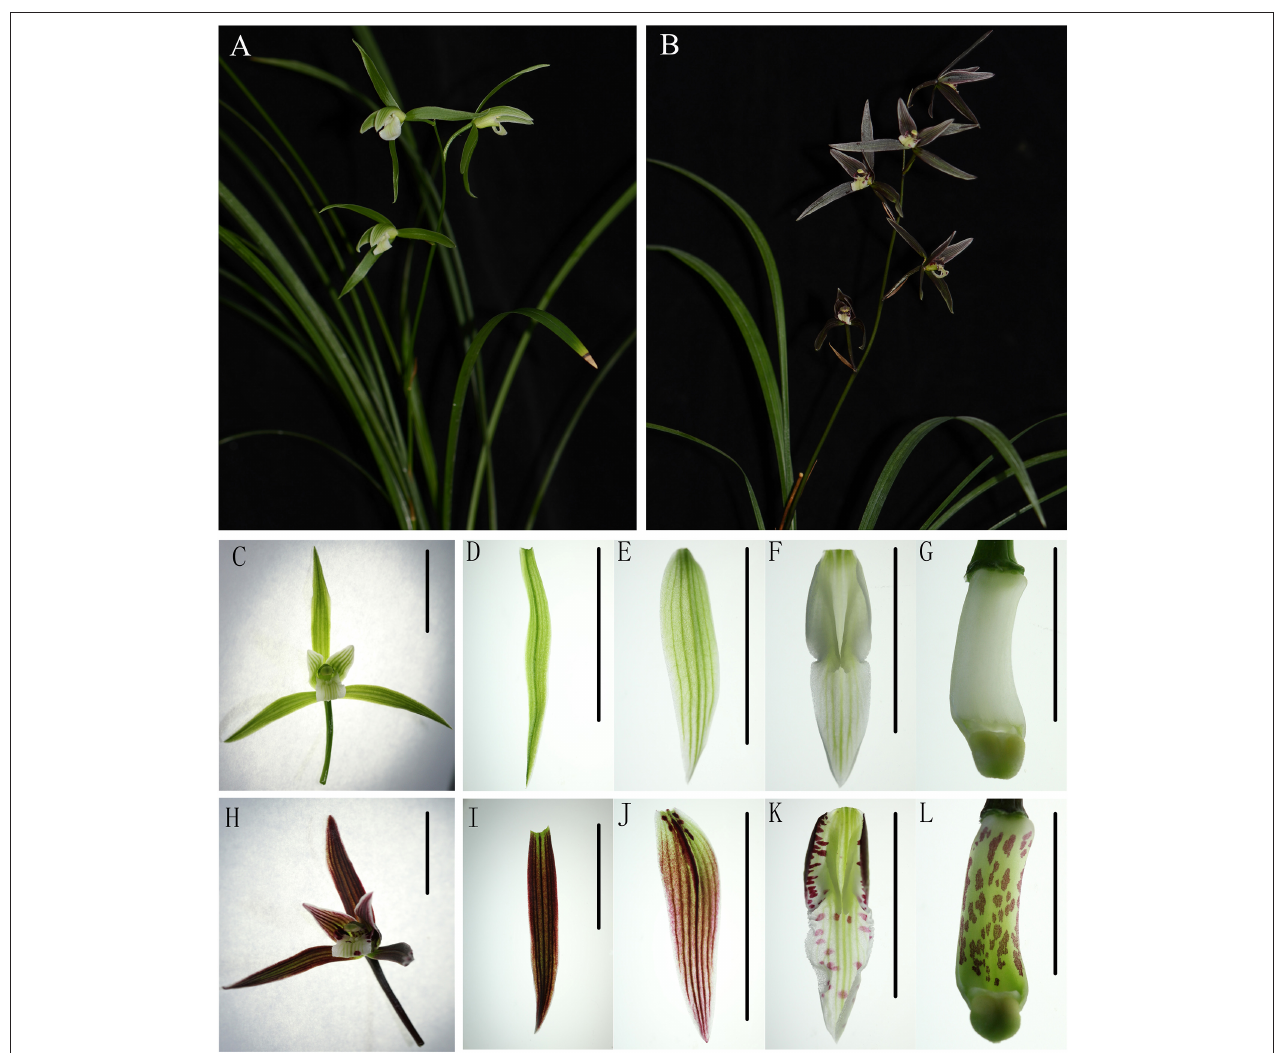
FIGURE 1 | The phenotype of purple-red and white Cymbidium kanran . (A) The plant of purple-red C. kanran . (B) The plant of white C. kanran . (C–G) Flower, sepal, petal, lip, and gynostemium of white C. kanran . (H–L) Flower, sepal, petal, lip, and gynostemium of purple-red C. kanran . Scale bar =